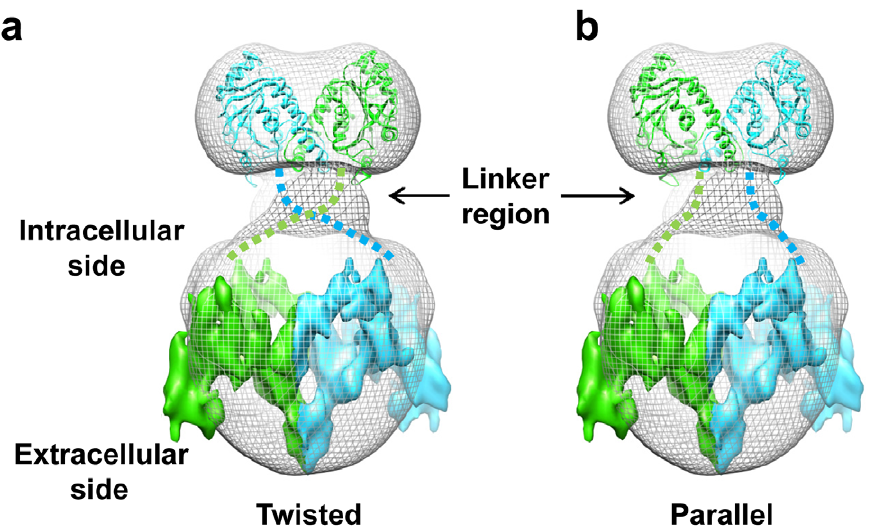
Figure 4. Two possible modes of monomer-monomer association in AE1 dimer. ( a ) The twisted mode of dimerization. ( b ) The parallel mode of dimerization. The crystal structure of cytoplasmic domain (ribbon) and 2D crystal structure of membrane domain (surface) are fitted into the single-particle reconstruction of full-length AE1 dimer (gray mesh) and the two monomers (each consisting of a cytoplasmic domain and a membrane domain) are colored in green or cyan, respectively. The tentative linkers connecting cytoplasmic and membrane domains are depicted as broken lines.